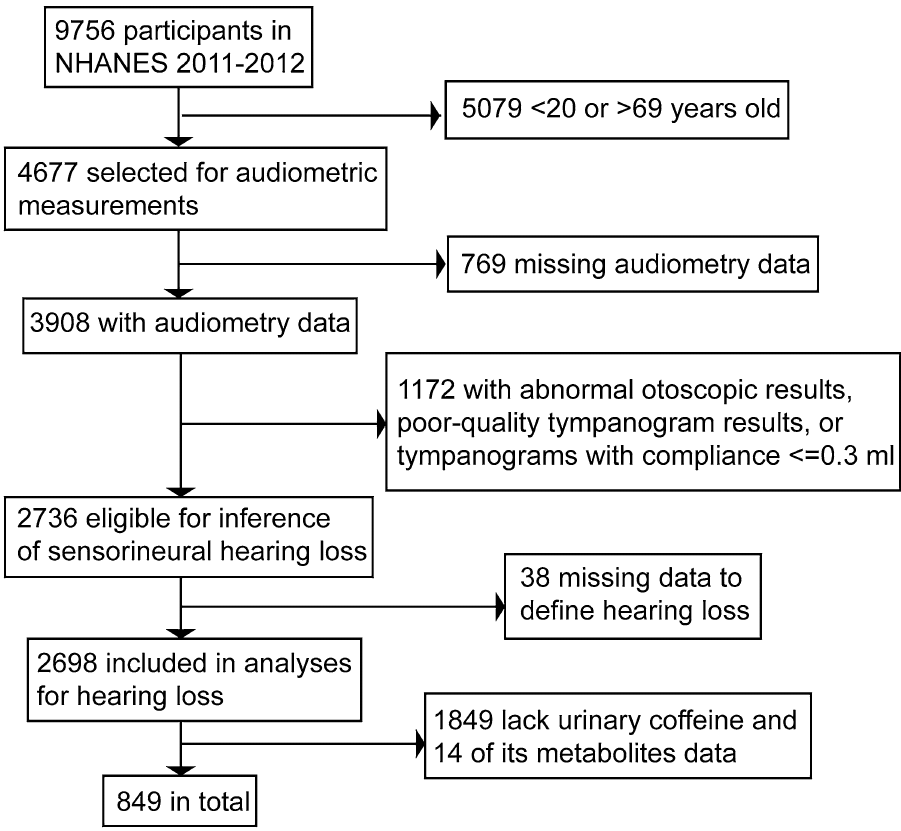
Figure 1. Flow chart of the selection process. NHANES national health and nutrition examination